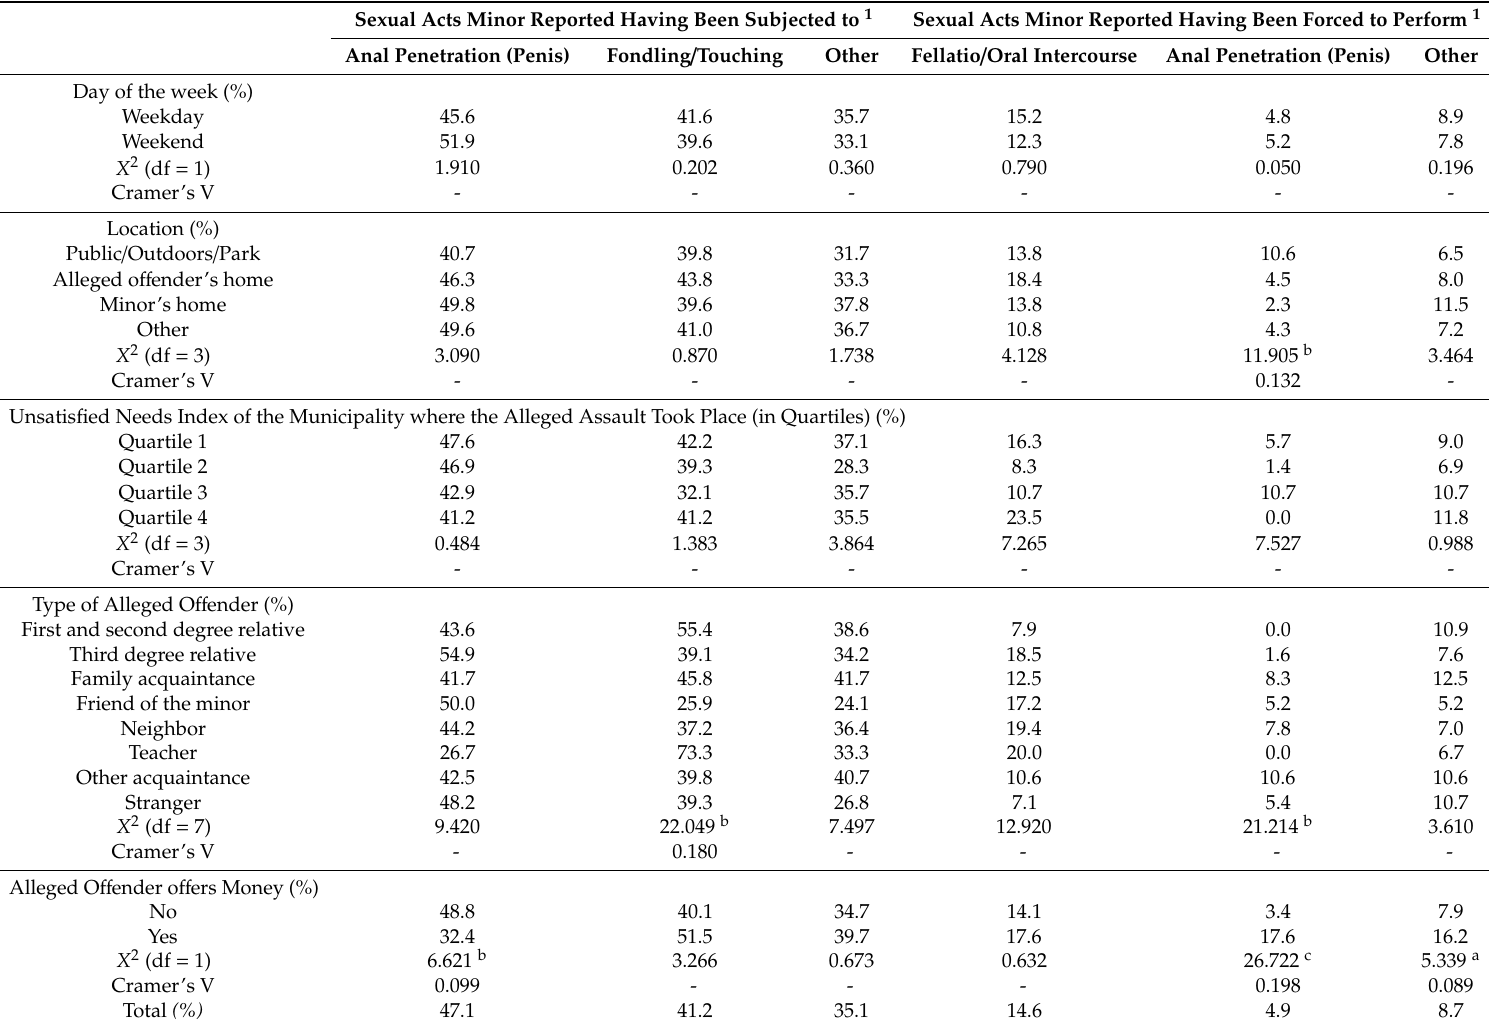
Table 4. Sexual acts the minor reported having been subjected to or forced to perform, by the details of the alleged assaults ( N =